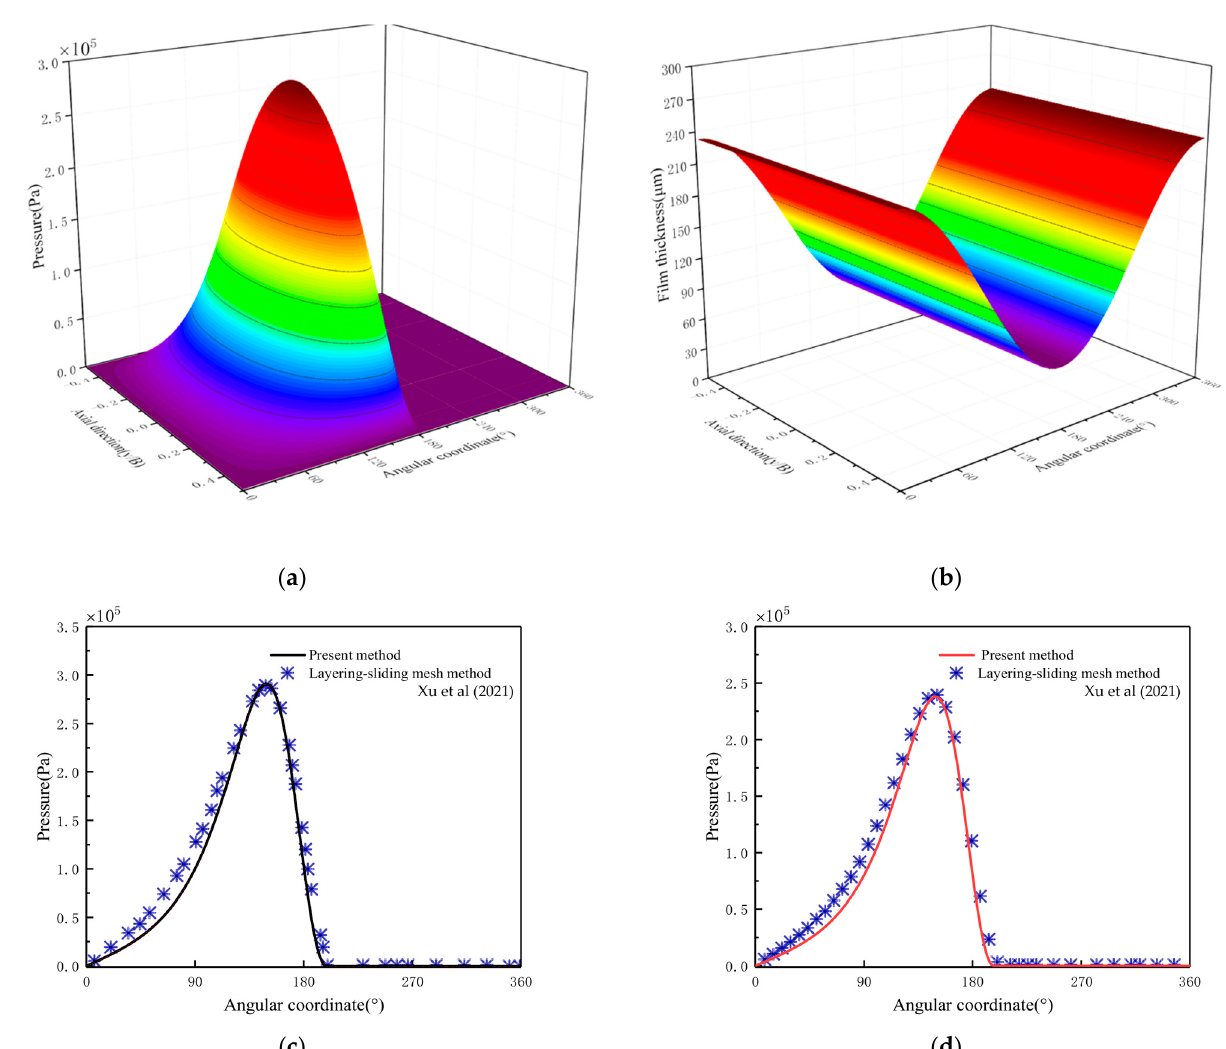
Figure 11. Comparison of calculation results of journal bearing. ( a ) Pressure distribution; ( b ) Film thickness distribution; ( c ) Central pressure; ( d ) Pressure at the location of b/4 [39].